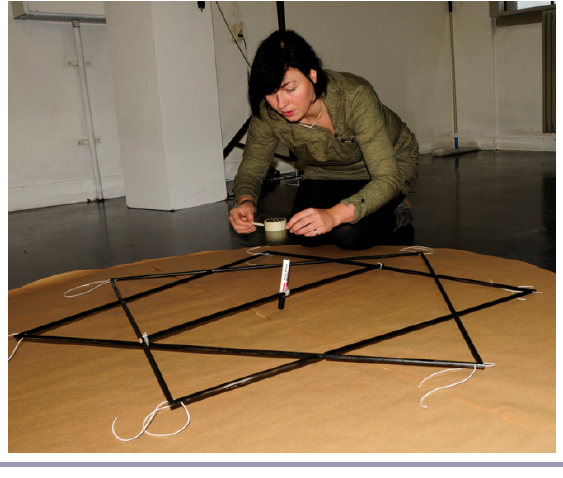
Fig. 6 . Oujia Drawing. The Ouija Drawing setup is being prepared using a round piece of paper and a structure to connect participants’ movements.